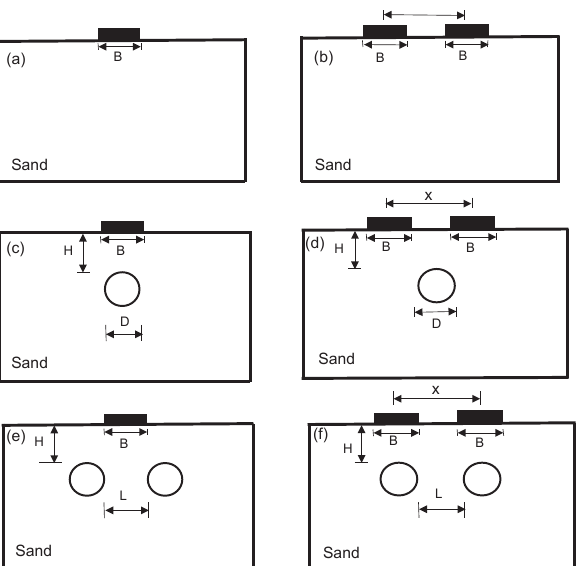
Figure 3: Interpretation of ultimate bearing capacity (qu) by Tangent Intersection